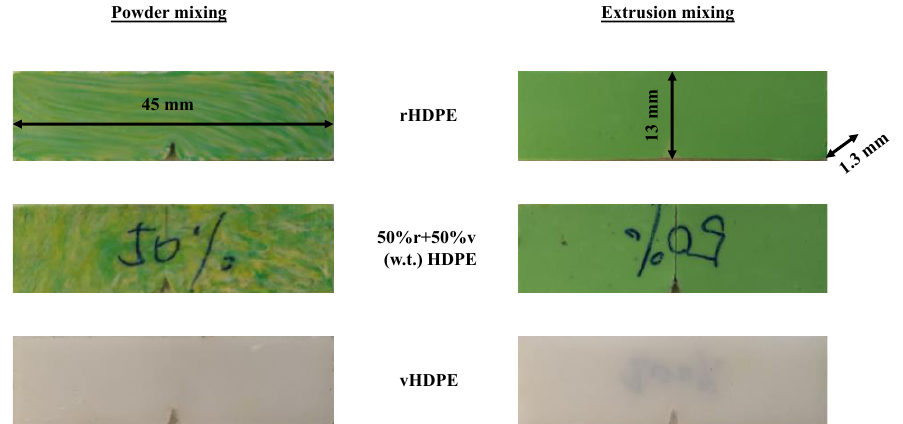
Figure 14. Appearance comparison (surface image) of typical specimens prepared by powder mixing ( left ) and extrusion mixing ( right ).